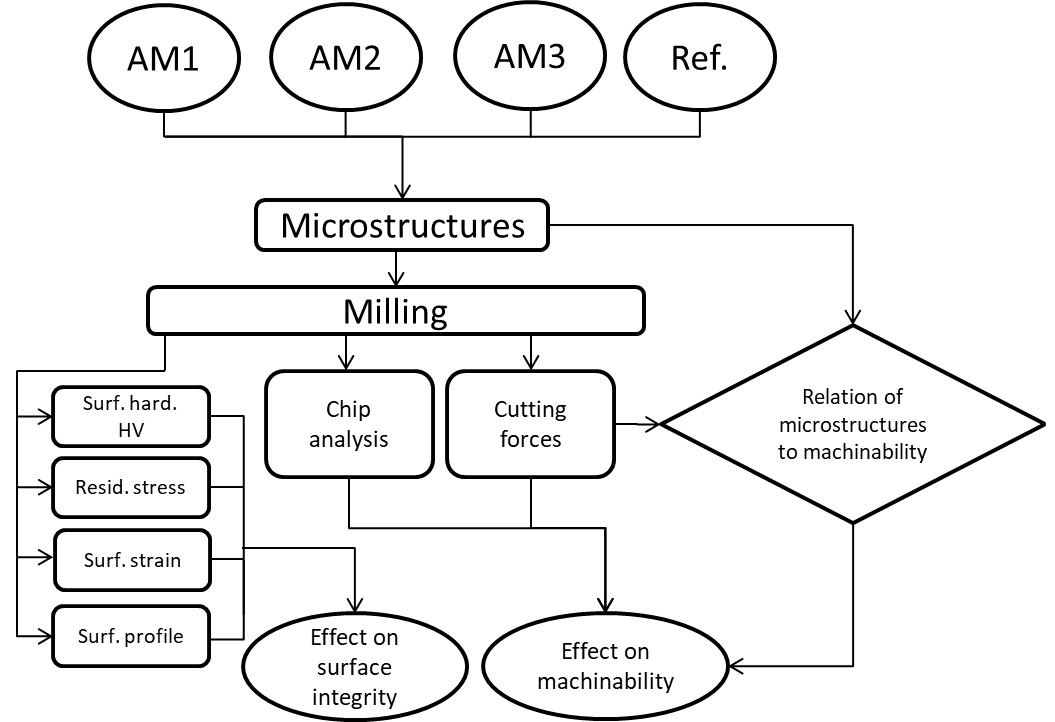
Figure 2. Flowchart showing the experimentation process. (AM, Additive Manufacturing; Ref., Reference; Surf., Surface; hard., hardness; Resid., Residual).